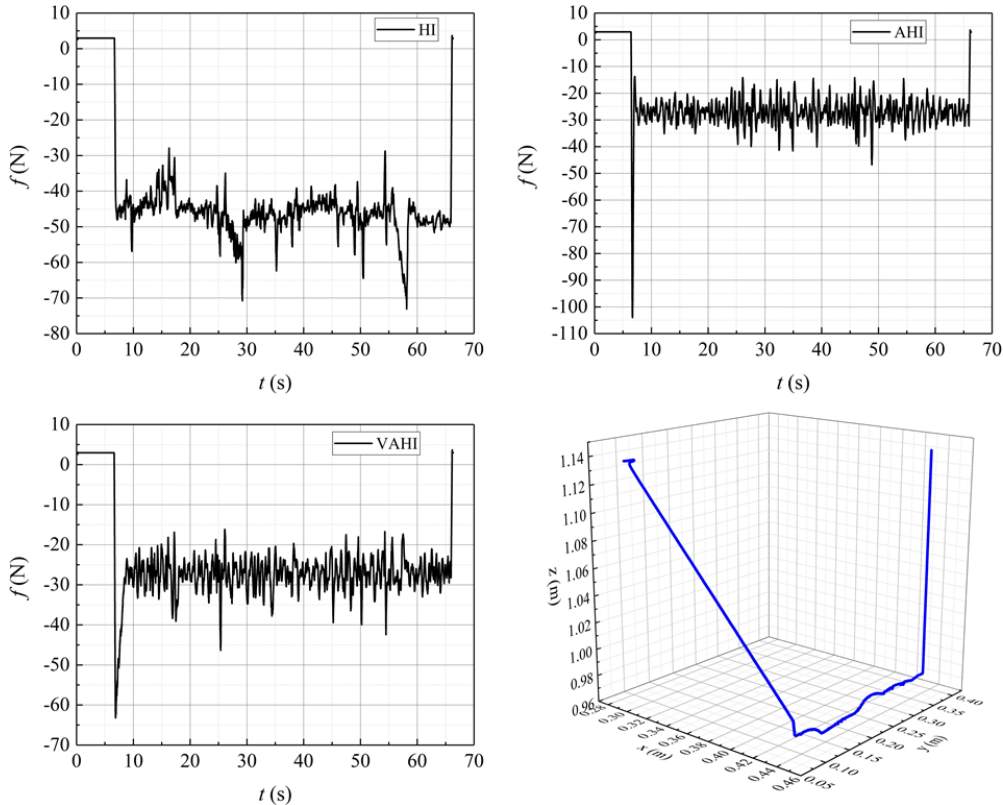
Figure 13. Tracking of the constant force with HI, AHI, and VAHI in the V-rep ultrasonic scenario.